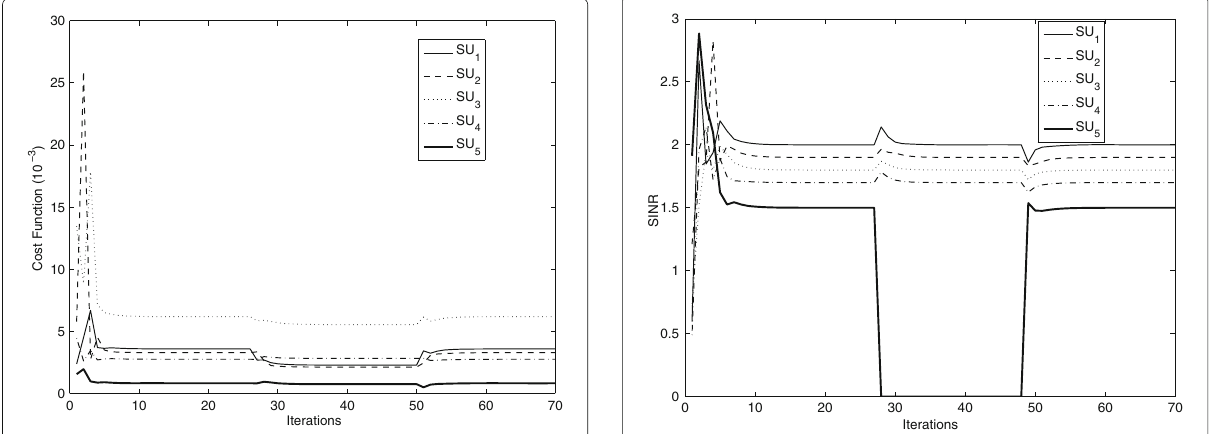
Fig. 8 The variations of SINRs versus the number of iterations for a variable number of